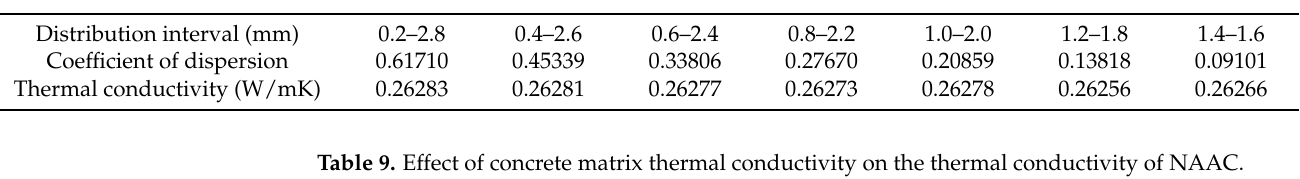
Table 8. Effect of pore diameter dispersion coefficient on thermal conductivity.